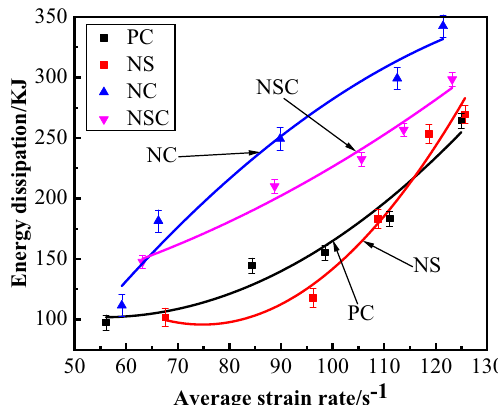
Figure 18. Relationship between energy dissipation and average strain rate of